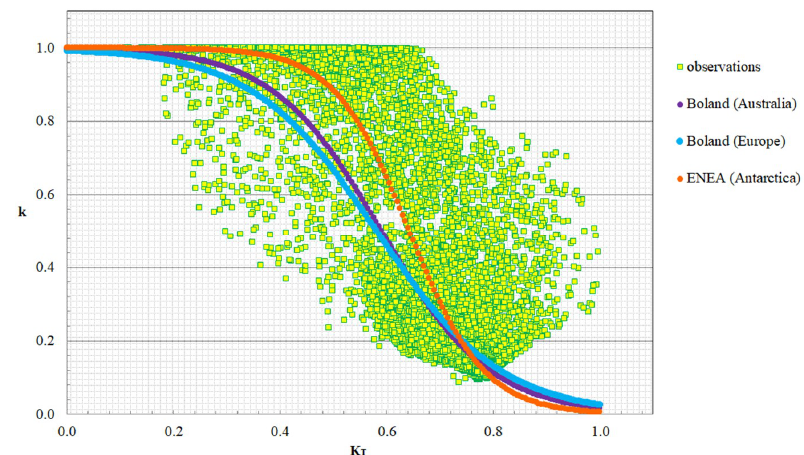
Figure 9. Dispersion graph of parameter pairs ( K T , k ) obtained from long GHI dataset using the Boland–Ridley model for the European (blue) and Australian (violet) regions [13] and the ENEA model for the Antarctic region (red).